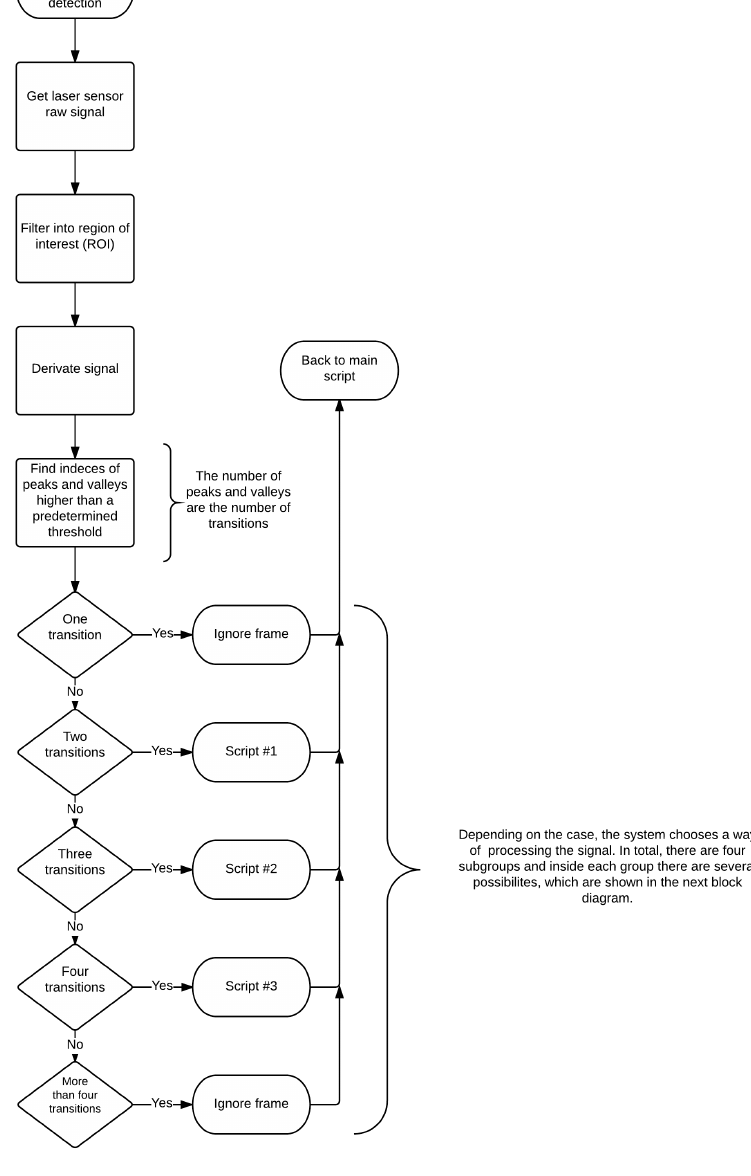
Figure 7. Flowchart used to infer the human position by finding where the legs are (main